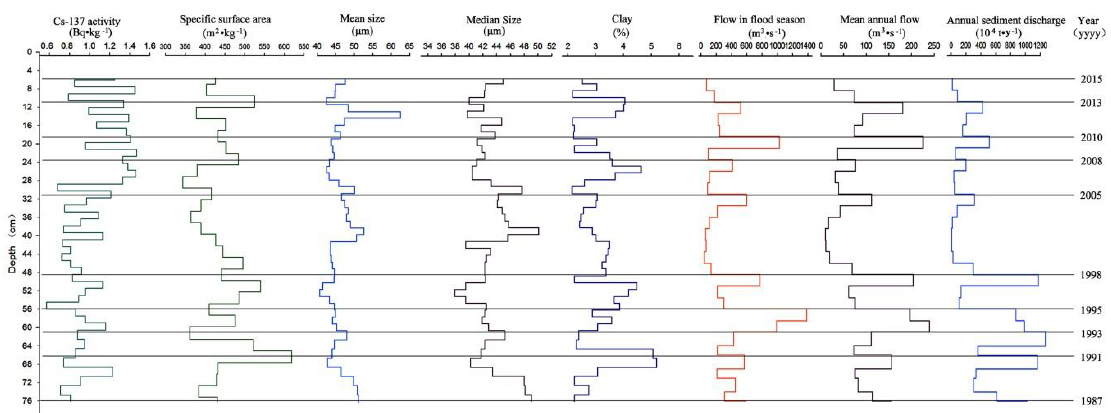
Figure 4. Relationship between the sediment grain size characteristics and the runoff index based on dating analysis.